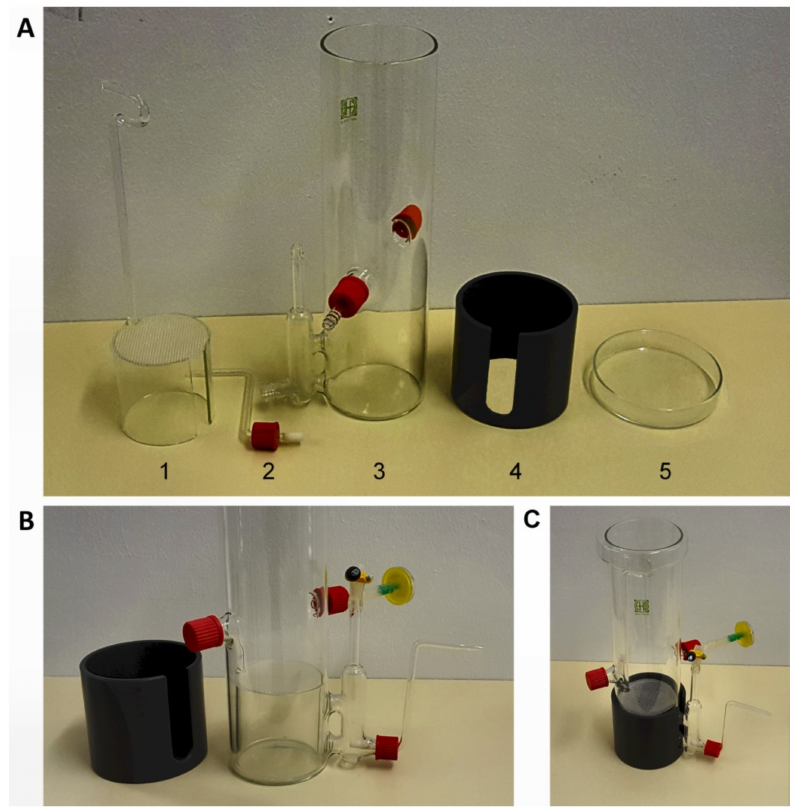
Figure 2. Bioreactor for sterile hydroponics and hairy root cultures. ( A ) Components of the bioreactor are (1) internal cylinder with a polypropylene mesh, (2) connector for air supply with a glass frit, (3) reactor body with an attached draft tube, (4) light-shielding external cylinder made of polyvinyl chloride, and (5) Petri dish serving as a lid. ( B ) Detailed view of a bioreactor fitted with an air